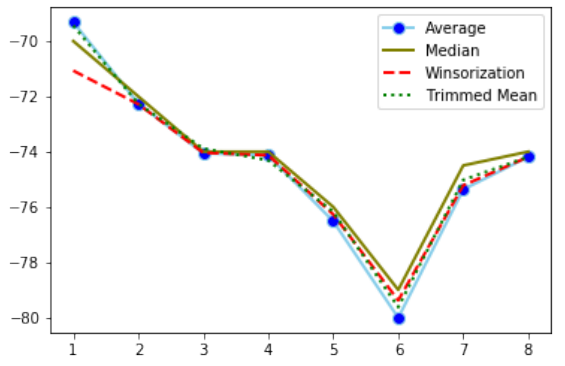
Figure 5. Filtered RSSI recordings using Band 2 in the hall.